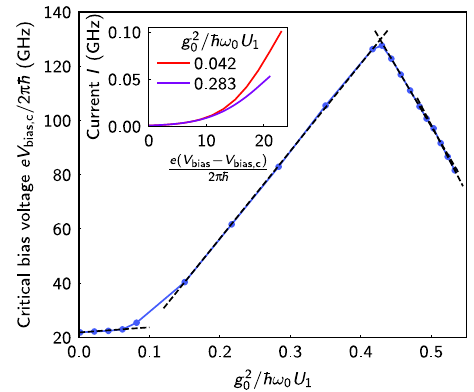
Fig. 4 Critical bias voltage V bias,c for different electron-phonon coupling strength. Below the critical bias voltage, the electric current is smaller than 10 − 3 GHz, a very small value (we show two examples of the current-voltage curves in the insert). The black dashed lines are linear fi ttings of critical bias voltage as a function of = _ ω g 2 0 U 1 for different electron-phonon coupling regions. Other 0 parameters are the same as in Fig.